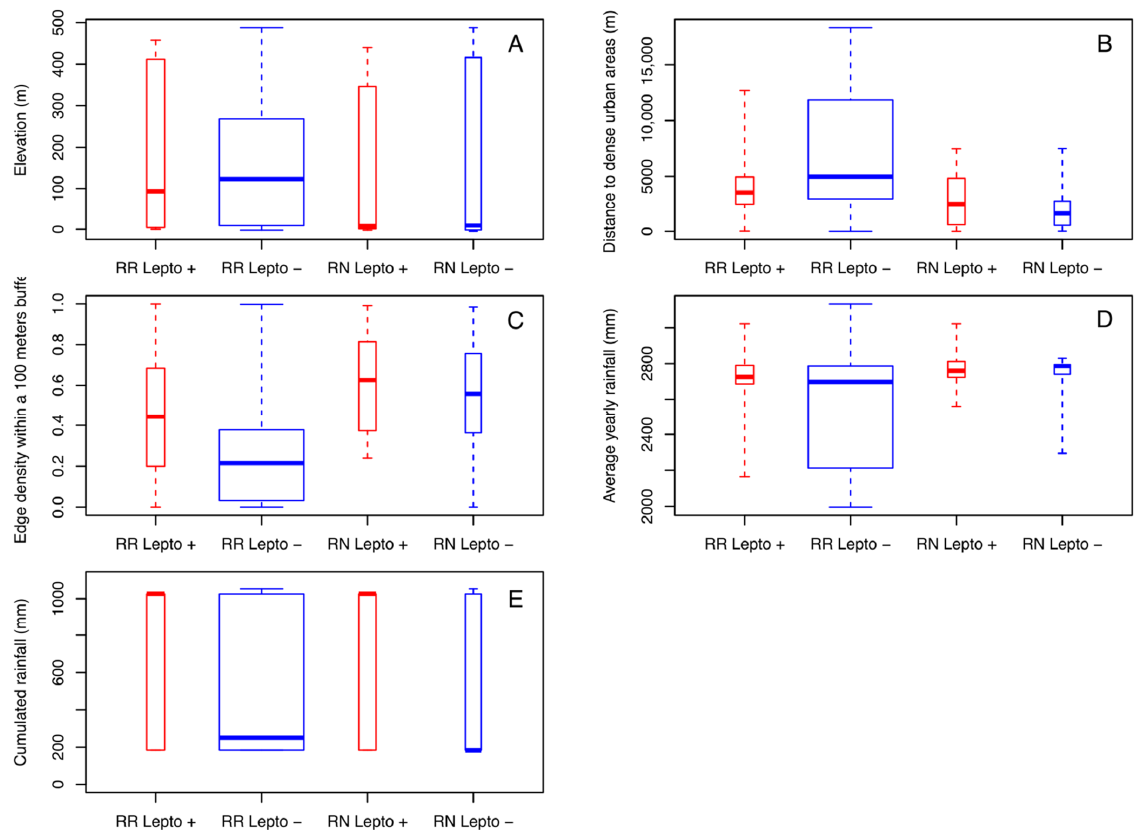
Figure 4. Boxplots of the most discriminant environmental variables, by species and Leptospira infection, measured from each sampling site: ( A ) elevation, ( B ) distances to dense urban areas, ( C ) edge density within a 100 m buffer, ( D ) average yearly rainfall, ( E ) cumulated rainfall during three months before capture.